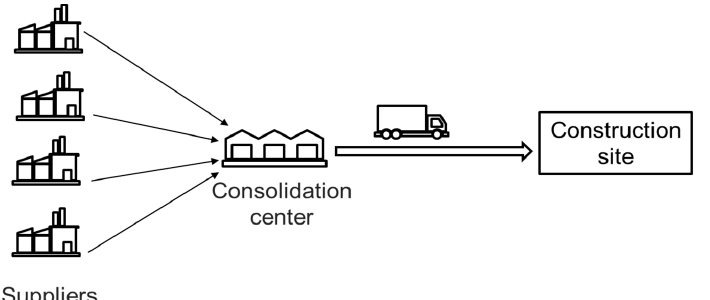
Figure 6. Kitting system based on a consolidation center before final delivery to the worksite. Figure 5d: Of 3/4 of the surveyed people, other stakeholders than the suppliers intervened in the